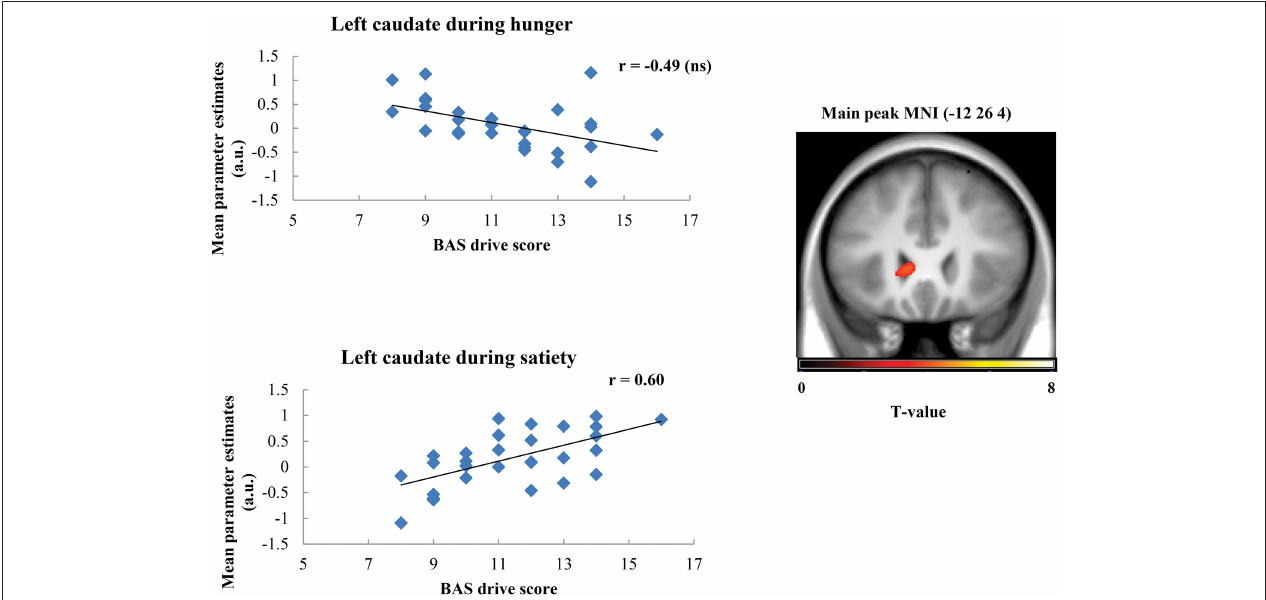
FIGURE 2 | Scatterplot of brain activation in response to oral calories (maltodextrin and sucralose minus sucralose) and reward sensitivity (BAS drive score) during hunger (not significant) and satiety (significant) in the left caudate.